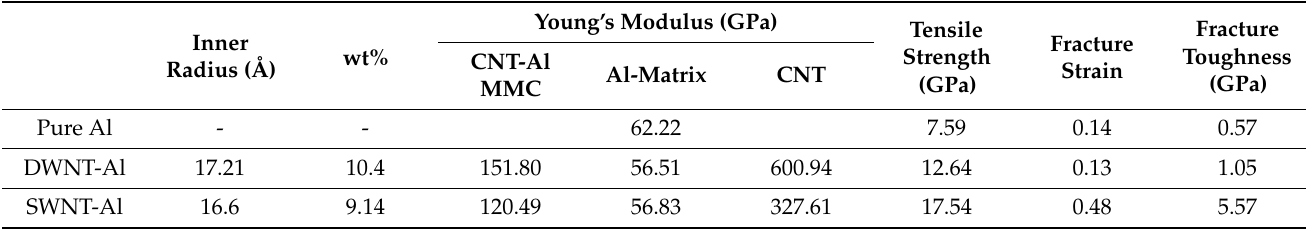
Table 1. Mechanical properties obtained from the stress–strain curves.